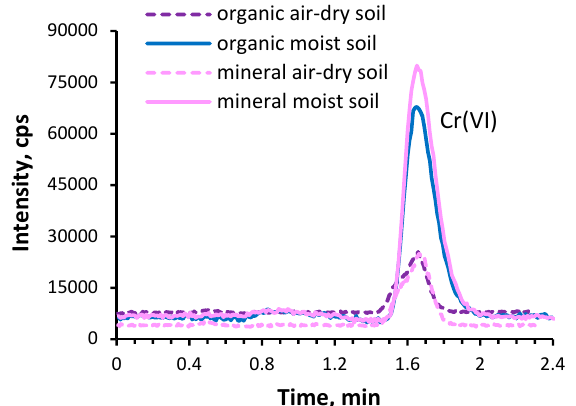
Figure 3. Chromatogram for chromium species in alkaline extracts of air-dry soil (100-fold diluted) and moist soil (50-fold diluted) spiked with insoluble BaCrO 4 , recorded at m / z 52. Recoveries of Cr(VI) from mineral and organic soil samples were slightly different (Table